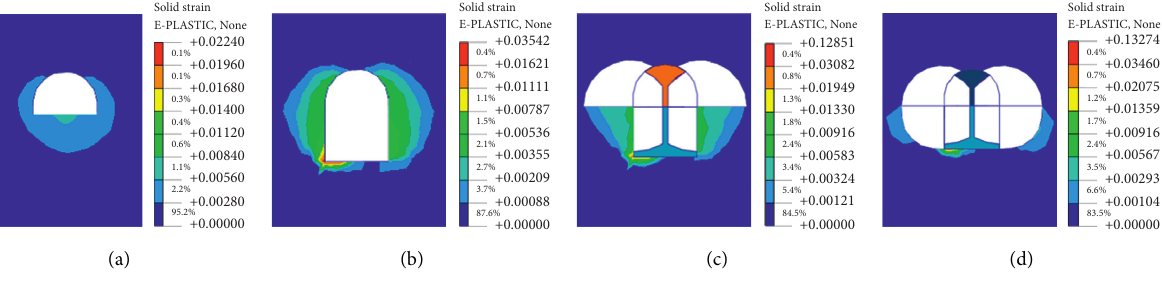
Figure 15: Distribution of plastic zone insurrounding rock.